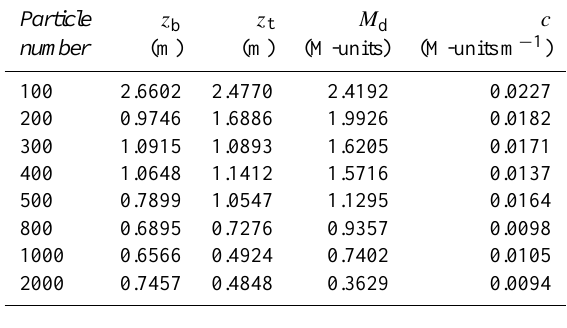
Table 1. RMSE values for different particles averaged over 10 MC runs.